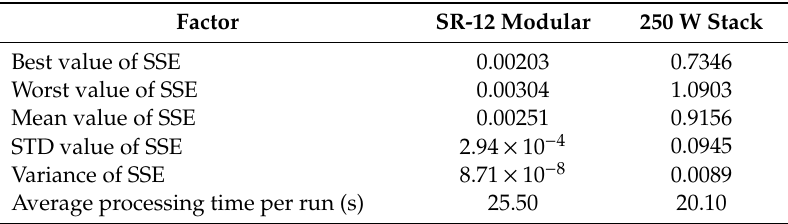
Figure 11. Characteristics of the 250 W stack at different temperatures. Table 6. ASO-adapted controlling parameters.